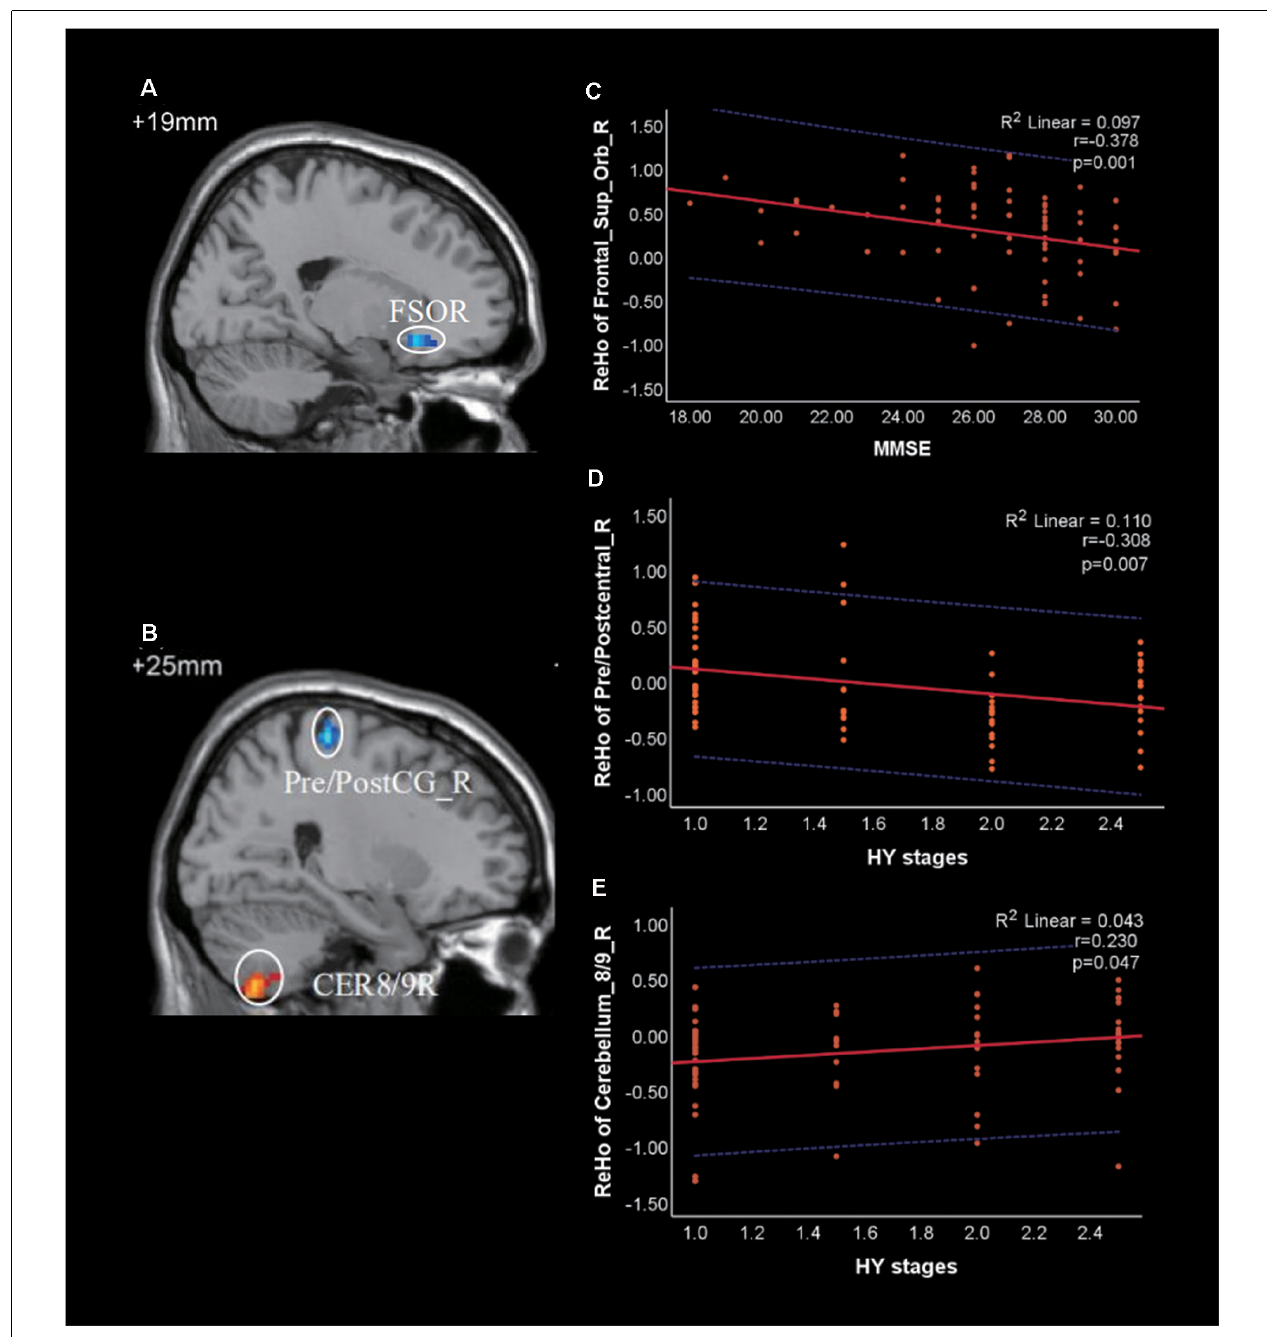
FIGURE 3 | Correlation of Regional Homogeneity (ReHo) between brain regions and clinical scale scores in patients with PD. (A) FSOR, Frontal_Sup_Orb_R; (B) CER8/9R, Cerebellum_8/9_R; Pre/PostC_R, Pre/postcentral_R. (C) The ReHo value of Frontal_Sup_Orb_R was negatively correlated with Mini-Mental State Exam (MMSE). (D,E) The ReHo value of Pre/Postcentral_R and Cerebellum_8/9_R were negatively and positively correlated with HY stages, respectively. The red solid line shows the existence of a significant correlation, while the blue dotted line depicts the 95% prediction interval for the red solid